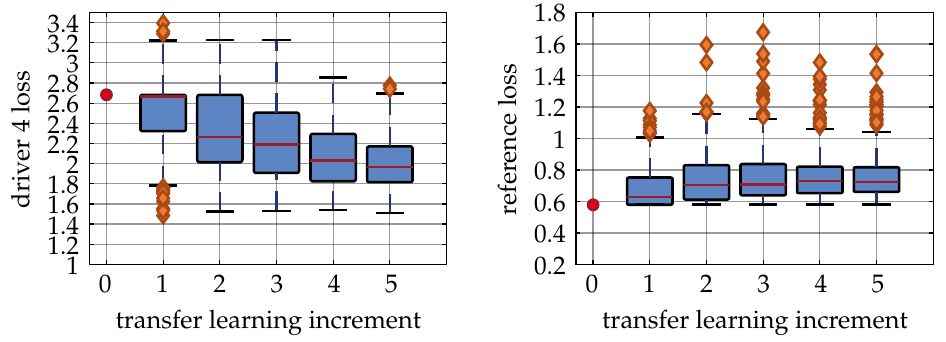
Figure 10. Training results for driver 3 (dynamic).